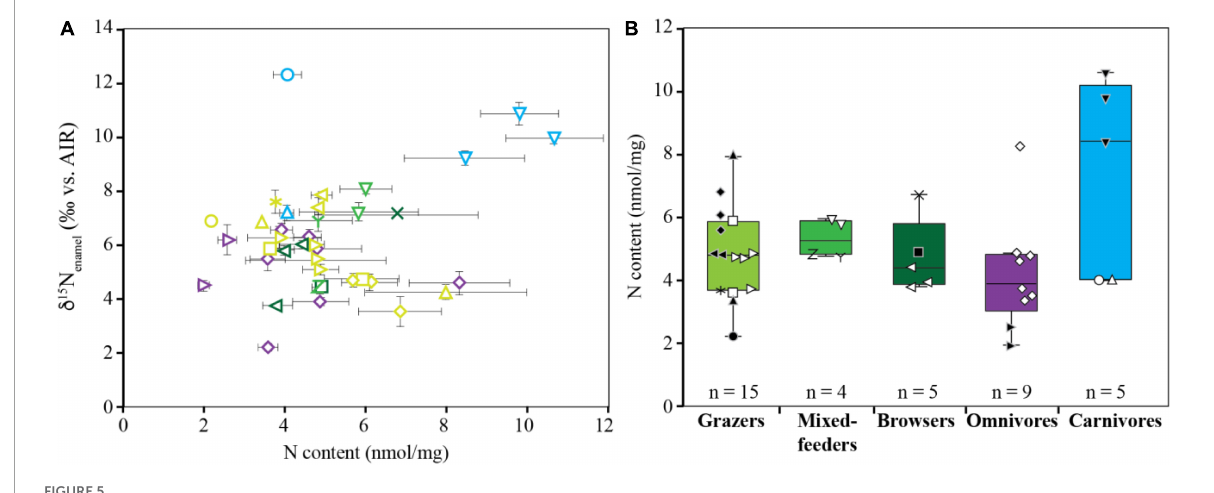
FIGURE5 Biplot of δ 15 N enamel values vs. N content of modern tooth enamel from GNP fauna (A) and N content grouped according to diet (B) . For taxon-specific symbols, refer to Figures 2 , 3 .